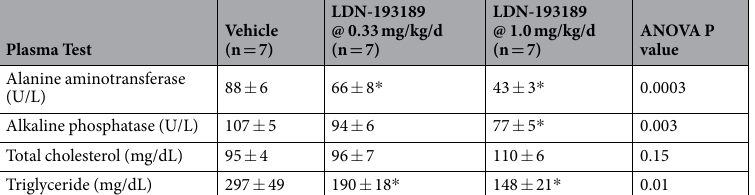
Table 1. Plasma markers of hepatic injury, cholesterol, and triglyceride levels in db/db mice treated with either vehicle or the BMP signaling inhibitor LDN-193189. Mean ± SEM; Trend P value from a 1-way ANOVA is indicated. * P < 0.05 compared to